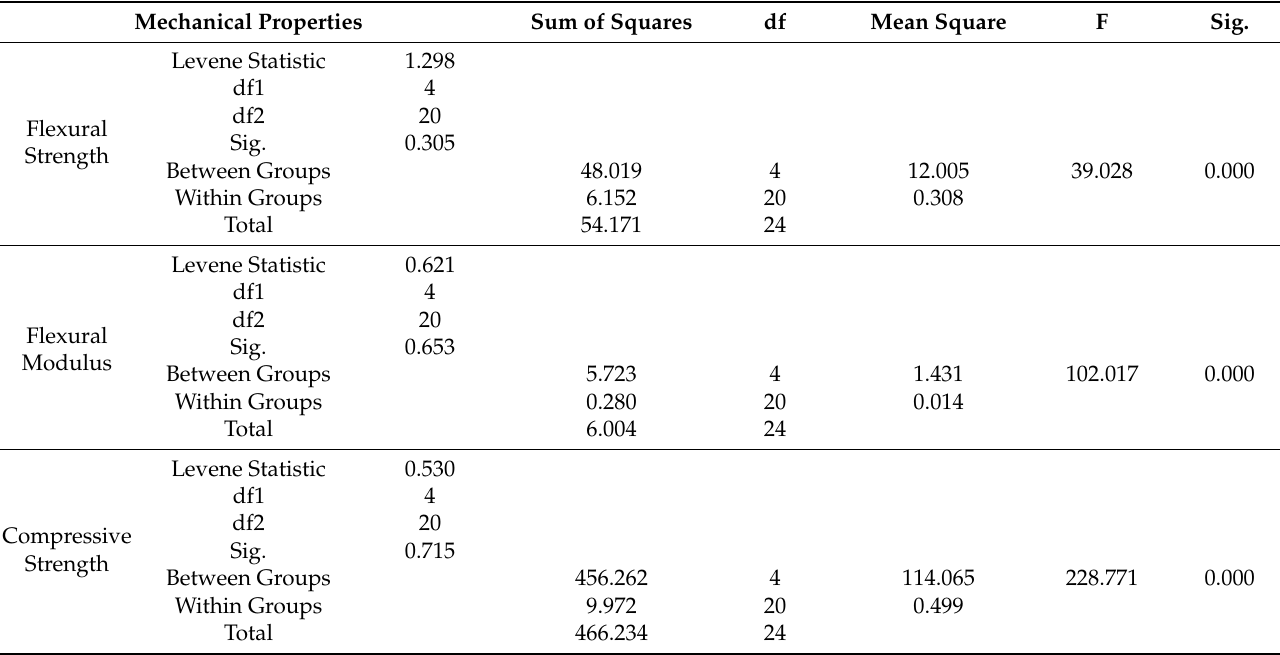
Table A4. Analysis of variance for mechanical properties with various milling